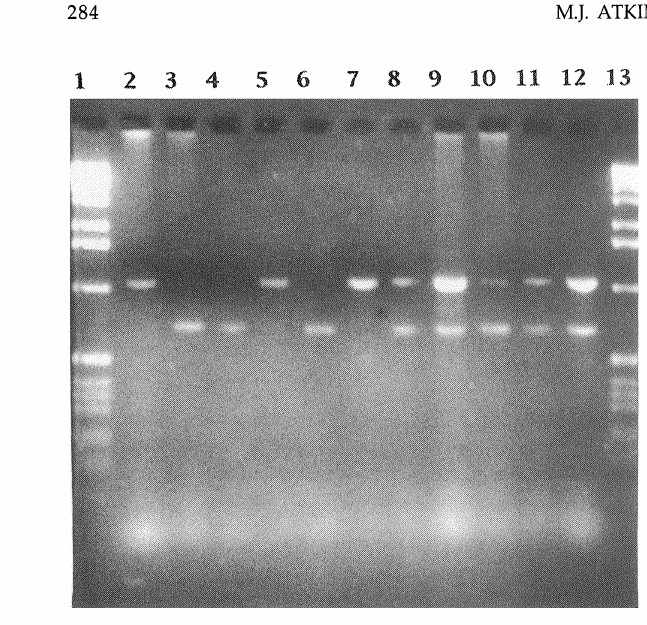
FIGURE 1. Amplification of DFL16.1JH and DSPJH structures: Two hundred fifty ng of DNA from cell lines were amplified singly or in pairs using the standard PCR assay. Lane 1: 1-kb ladder; lane 2:CB135 (DFL16.1JH2); lane 3: CB172(DSPJH3); lane 4:CB134 (DFL16.1JH3); lane 5:CB43 (DSPJH2); lane 6: CB82(DSPJH3); lane 7: CB4(DFL16.1JH2); lane 8: CB43(DSPJH2)